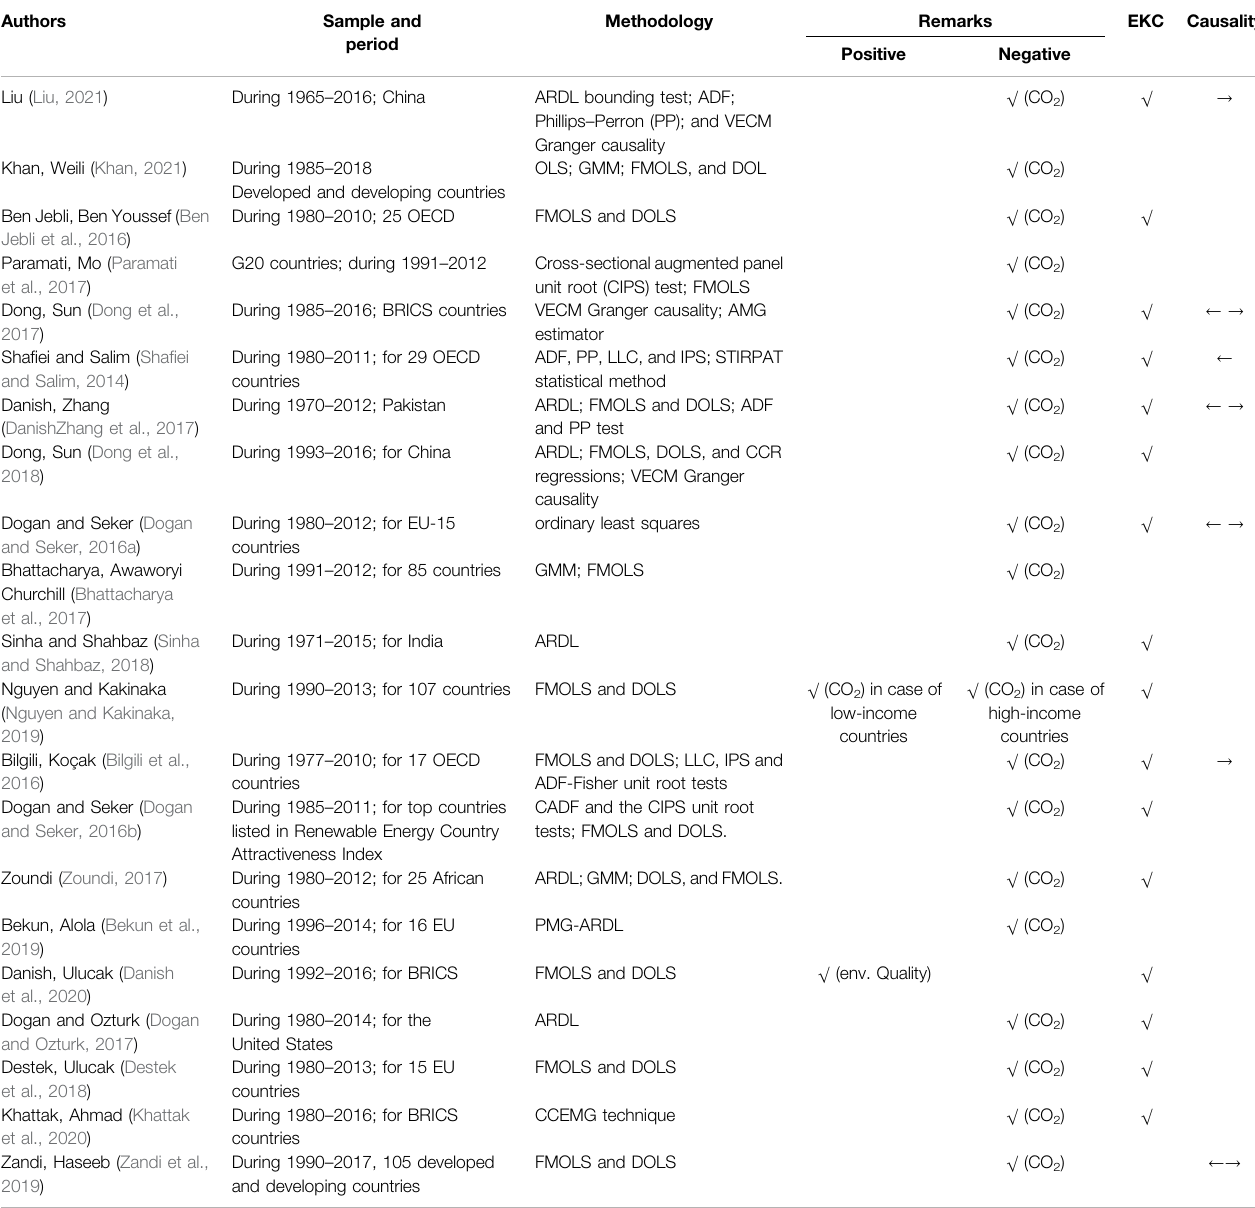
TABLE 1 | Summary of literature survey: nexus between RE and environment.